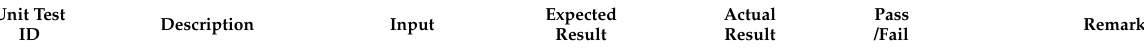
Table A1. Unit testing cases of showing the chemical element in substantial nature.